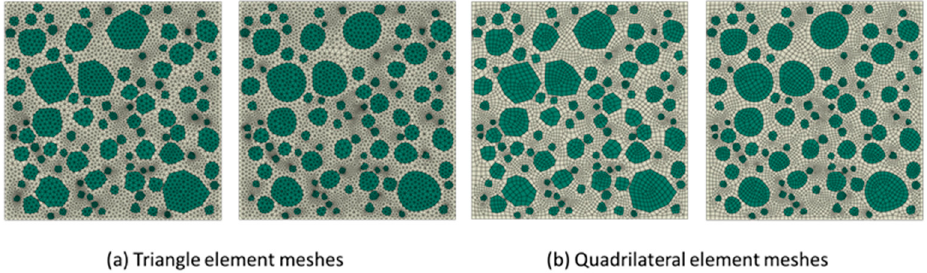
Figure 16. Low-sphericity and well-rounded stone concrete models under different aggregate volume fractions, ( a ) 40%, ( b ) 50%, ( c ) 60%, and ( d ) 70%, respectively, with the scale factor between long and short axes, f ∈ [1,3].